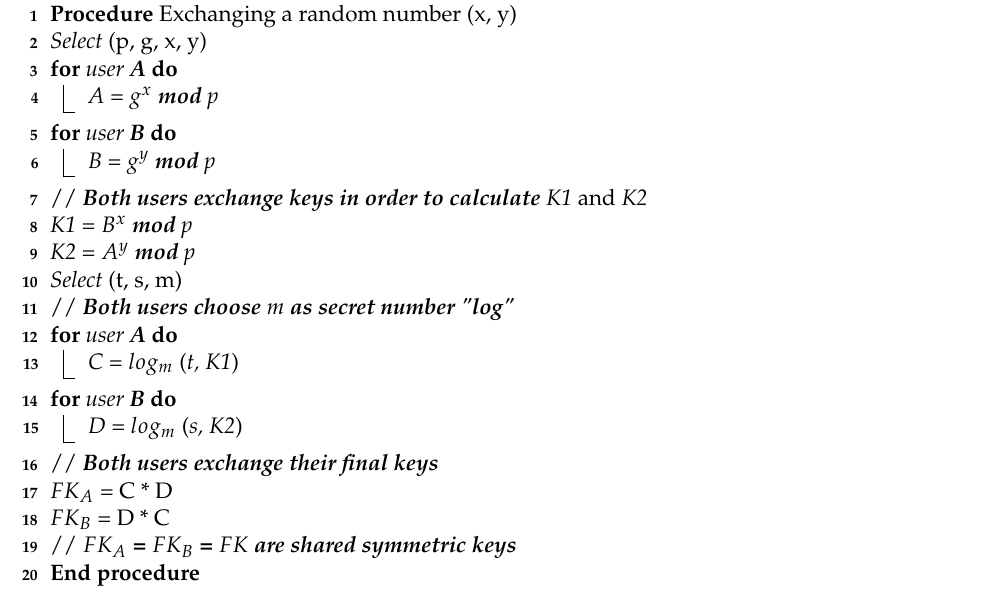
Algorithm 1: Modifying the process of D-H keys exchange algorithm.